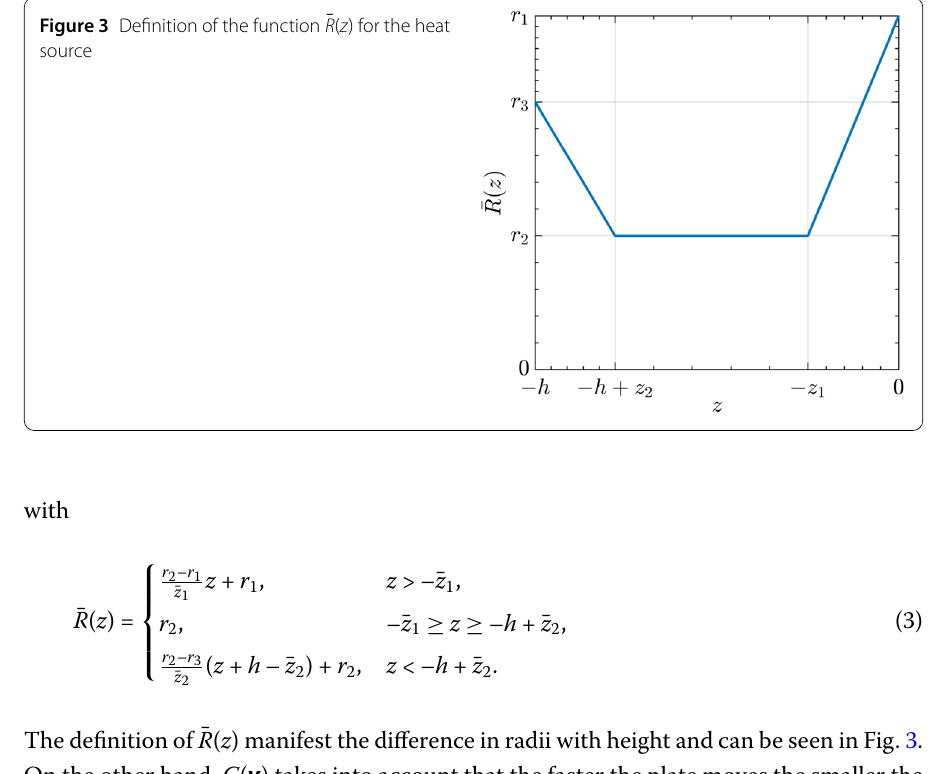
Figure 3 Definition of the function ¯ R ( z ) for the heat